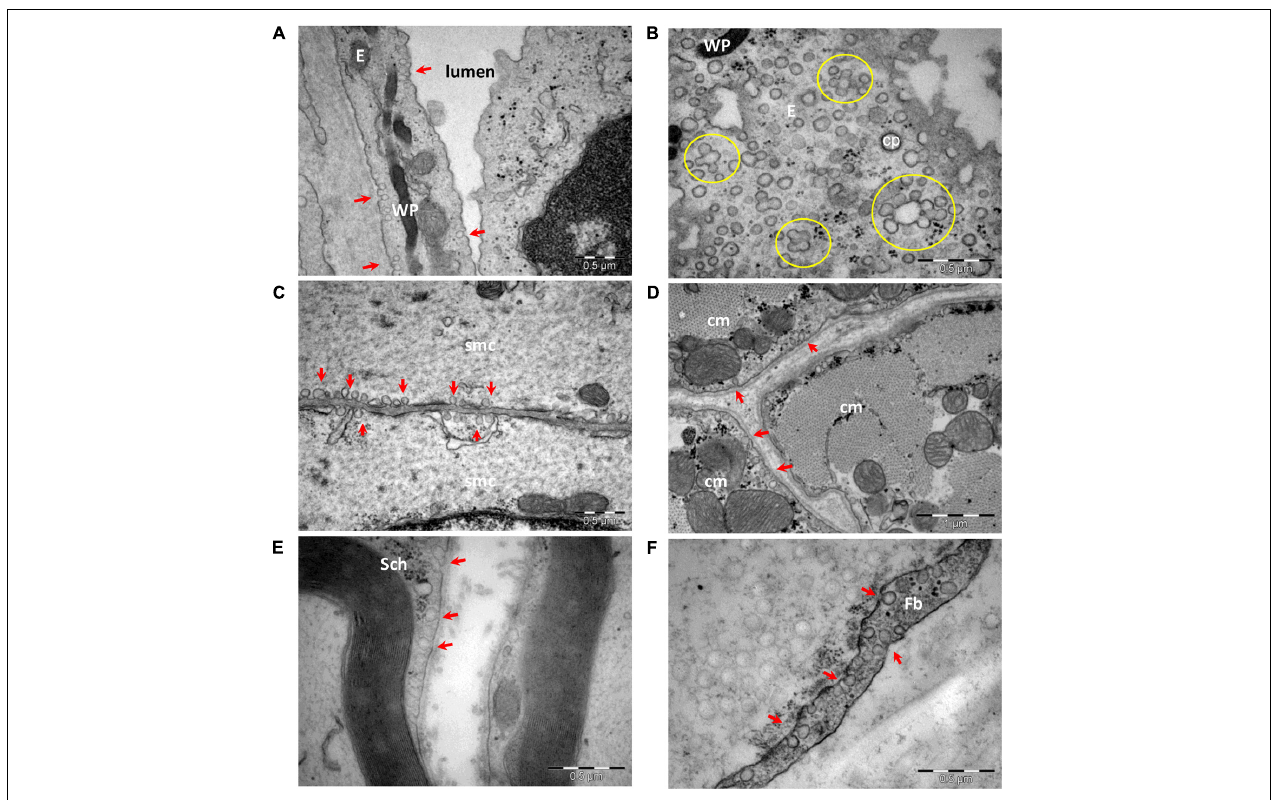
FIGURE 1 | Transmission electron microscopy of cells with caveolae (arrows): endothelial cells (A,B) , smooth (C) and striated (D) muscle cells, Schwann cell (E) , and perineurial fibroblast (F) . Caveolae in a section parallel to an endothelial cell plasma membrane (B) shows numerous caveolae as single units or clustered forming rosettes (encircled). E, endothelial cell; cp, clathrin-coated pit; WP, Weibel–Palade bodies in endothelial cell; smc, smooth muscle cell; cm, cardiac muscle cell; Sch, Schwann cell; Fb, fibroblast (image collection, Department of Ultrastructural Pathology, “Victor Babes” Institute of Pathology,